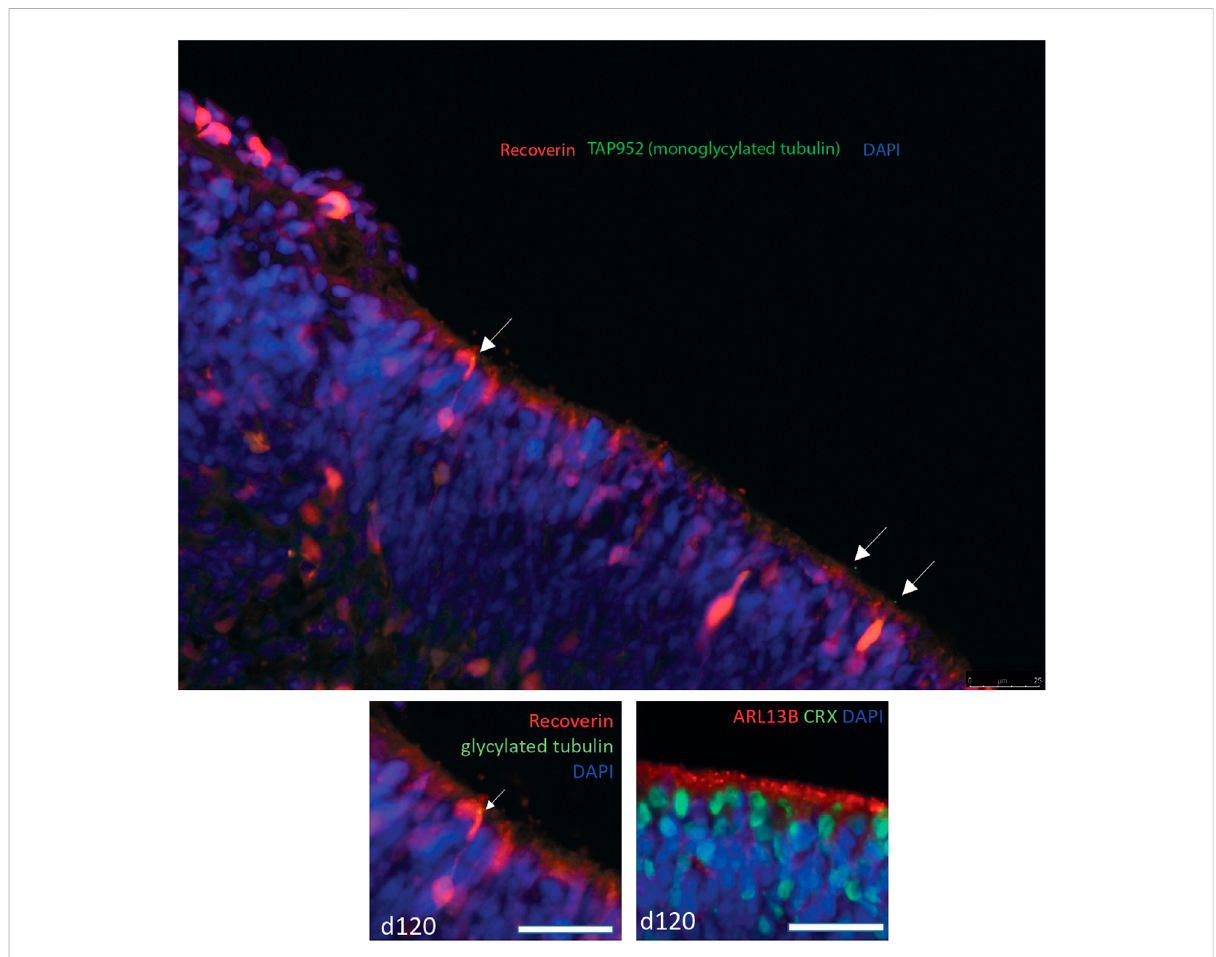
FIGURE 6 Confocal microscopy image of immunostaining of day 120 human embryonic stem cell derived retinal organoids. Recoverin is stained in red, monoglycylated tubulin is stained with TAP952 antibody in green, nuclei are stained with DAPI in blue. Monoglycylated tubulin staining is seen in recoverin positive cells in puncta reminiscent of basal bodies of connecting cilia (white arrows). The lower panel shows a magni fi ed insert of the top panel (left) and a panel at the same magni fi cation of the same D120 organoid stained with ARL13B (red) as a marker for cilia and CRX (green) photoreceptor cell